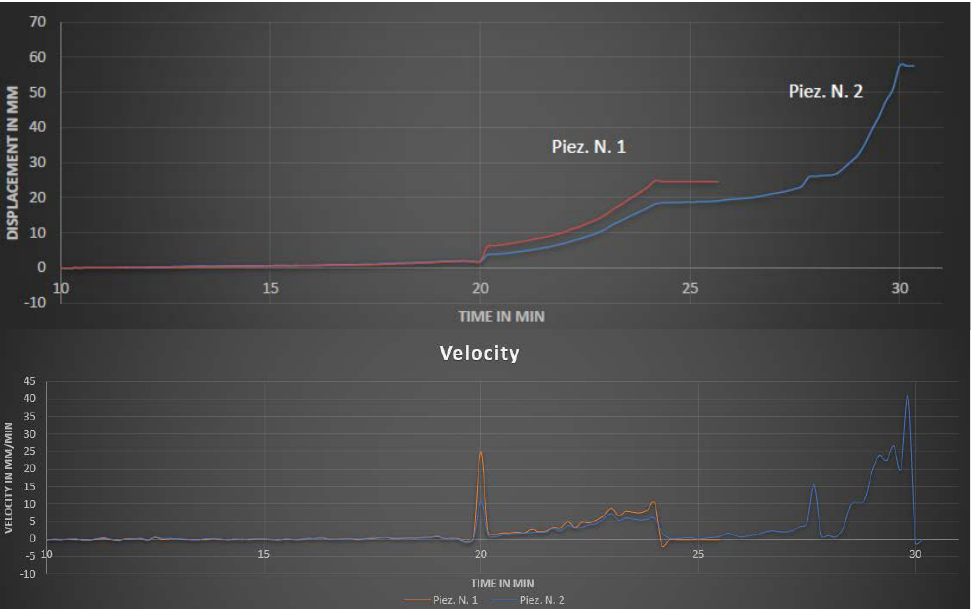
Figure 6. Plots displaying displacements (on the top) and corresponding velocities (on the bottom) of Piezometers 1 and 2, as measured using DIC analysis of the image sequence from GoPro 4 Black ® camera No.